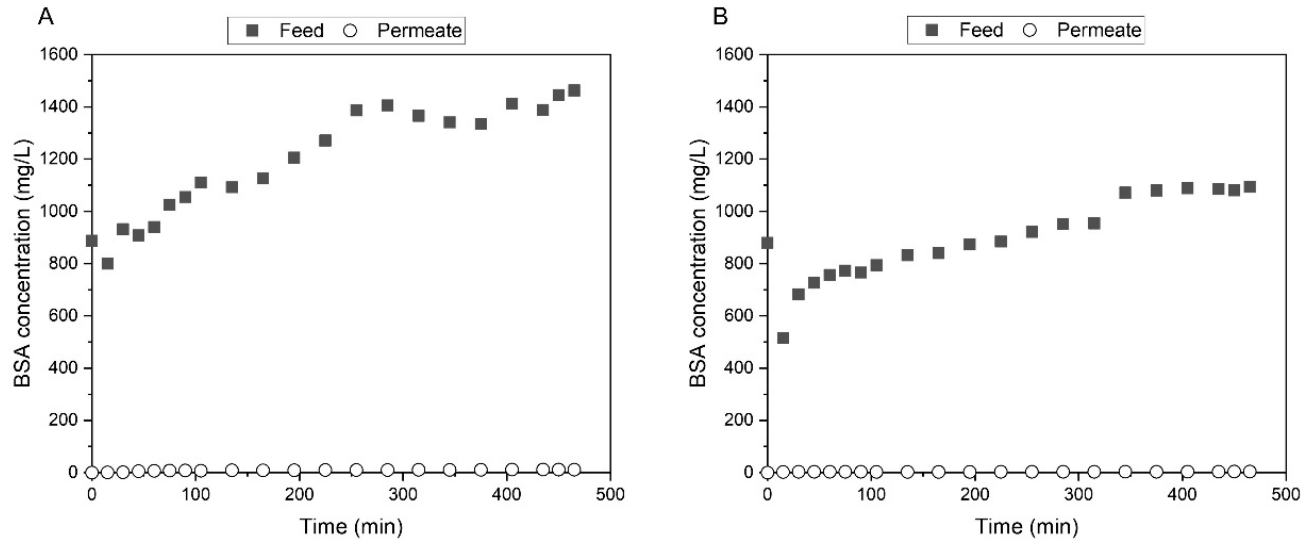
Figure 10. BSA concentration profiles for CA-SiO 2 -(CH 2 ) 3 NH 2 ( A ) and CA ( B ) membranes, regarding feed ( ■ ) and permeate ( ○ ) samples, for a total experiment time of 465 min.